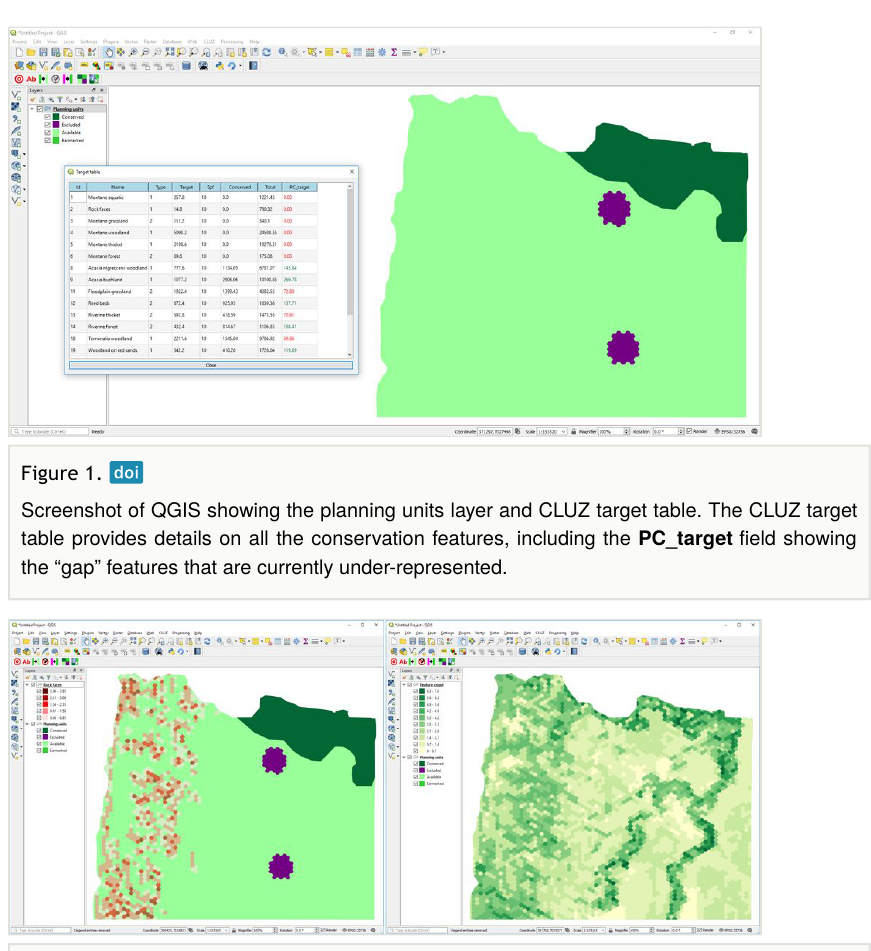
Screenshots of QGIS showing on the left, a CLUZ distribution map of one of the conservation features, and on the right a map of the number of conservation features found in each planning